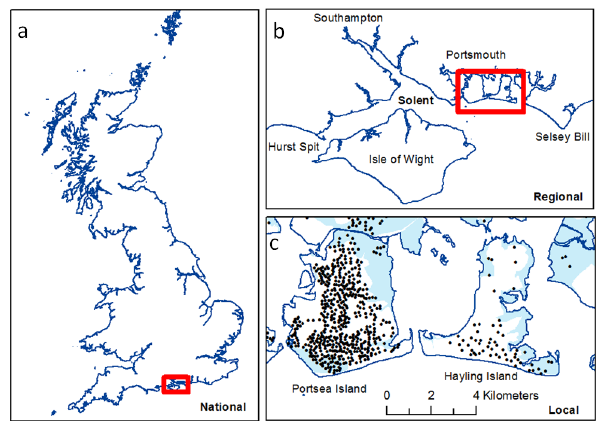
Figure 2. (a) and (b) Location of Portsea and Hayling Islands. (c) Centroid points for population data assigned to the 2011 UK na- tional Census and the Environment Agency’s 1 in 200 year indica- tive floodplain map (IFM, shaded blue) (Centroid points are Crown copyright/database right 2013. An Ordnance Survey/EDINA sup- plied service. IFM is © Environment Agency copyright and database rights